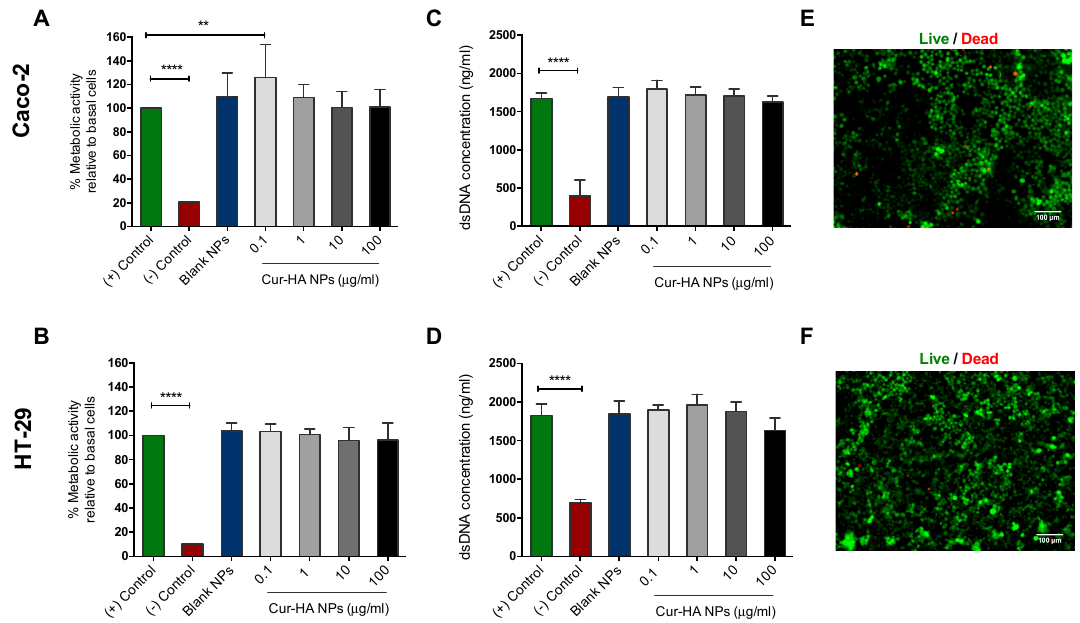
Figure 4. Cytotoxicity studies of Cur-HA-NPs on colon epithelial like cells (Caco-2, HT-29) . Alamar Blue assay of blank, Cur-HA NPs (0.1, 1, 10 and 100 µ g / mL), (Media alone-positive control) (DMSO treated- negative control) treatment for cell metabolic activity on Caco-2 and HT-29 cell lines ( A , B ). Picogreen assay of blank, Cur-HA NPs (0.1, 1, 10 and 100 µ g / mL) treatment for cell proliferation on Caco-2 and HT-29 cell lines ( C , D ). Live / Dead assay images of Caco-2, HT-29 cells after 24 h nanoparticle treatments at 10 × magnification ( E , F ). The results are expressed for each treatment as ( n = 3); data are expressed as the mean ± SD. P values were determined by one-way ANOVA with Dunnett’s post hoc test to determine di ff erences between treatments and control group; ** p < 0.01 for control vs. 0.1 ug / mL Cur-HA NPs in the Caco-2 cells, **** p < 0.0001 for ( + ) control vs. ( − ) control respectively. No significant di ff erences were noted in the HT-29